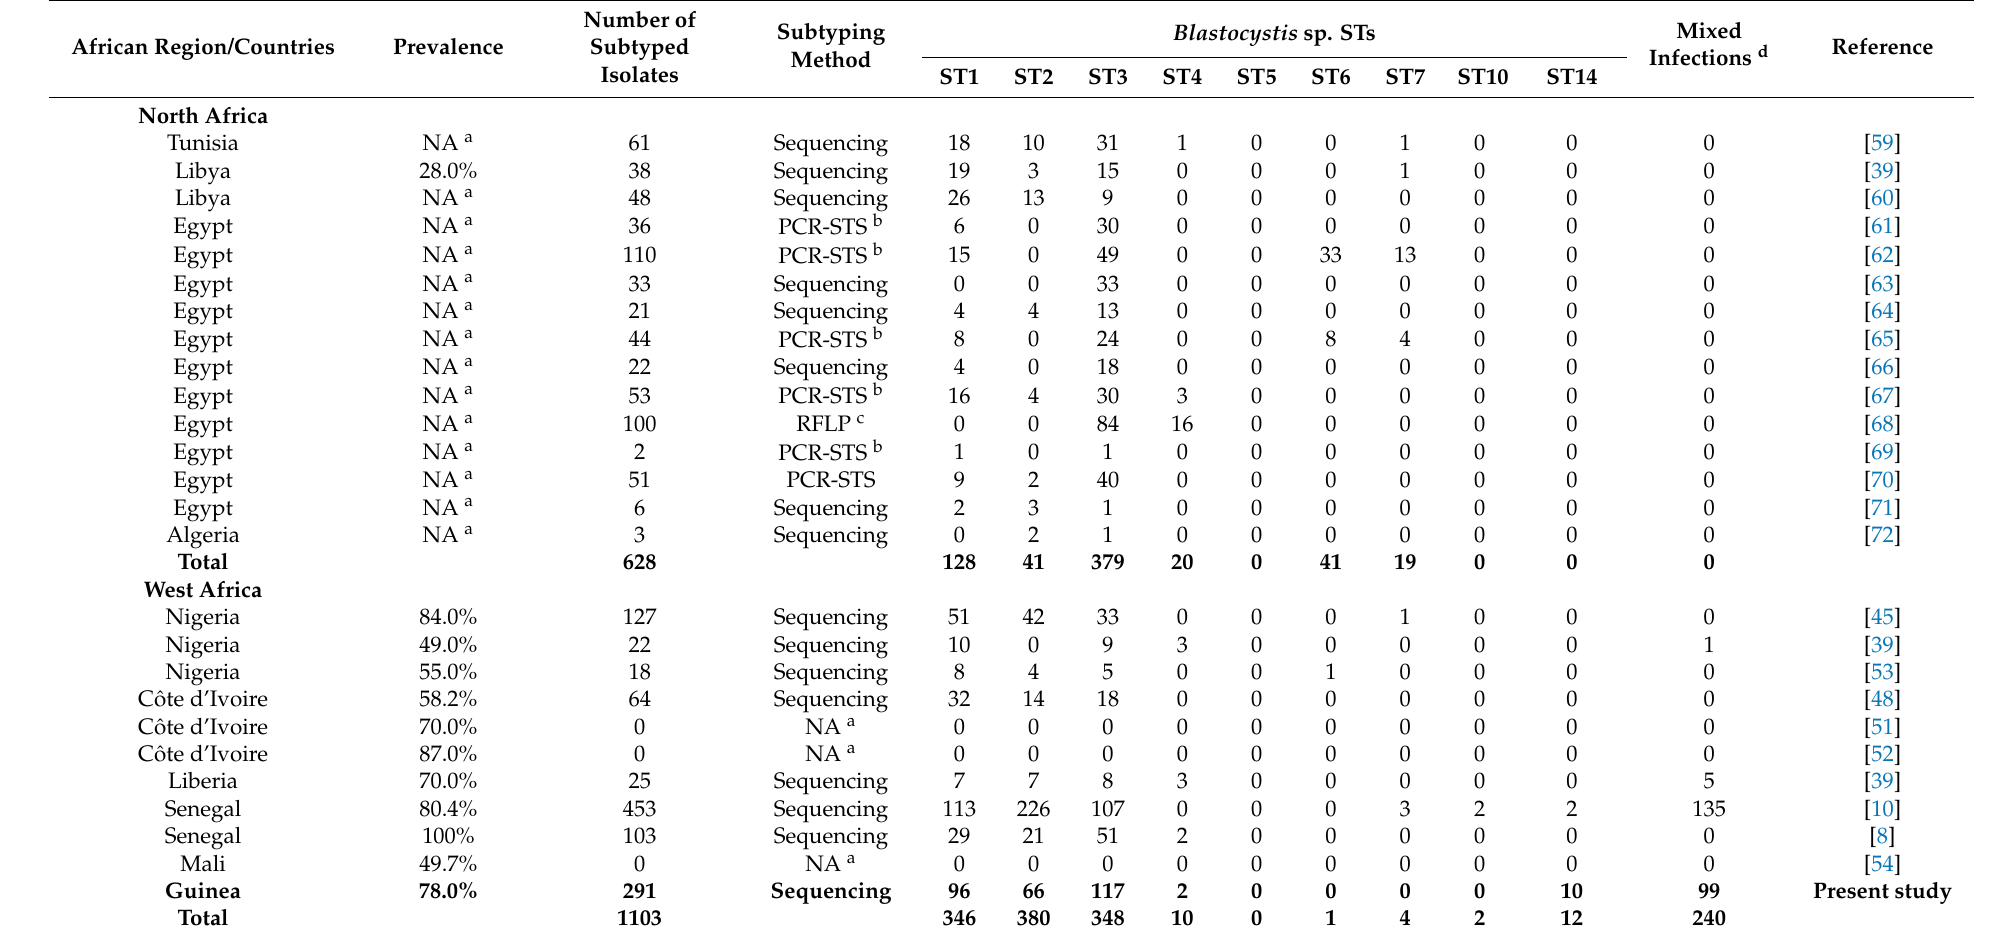
Table 4. Prevalence and ST distribution of Blastocystis sp. in African countries (completed from